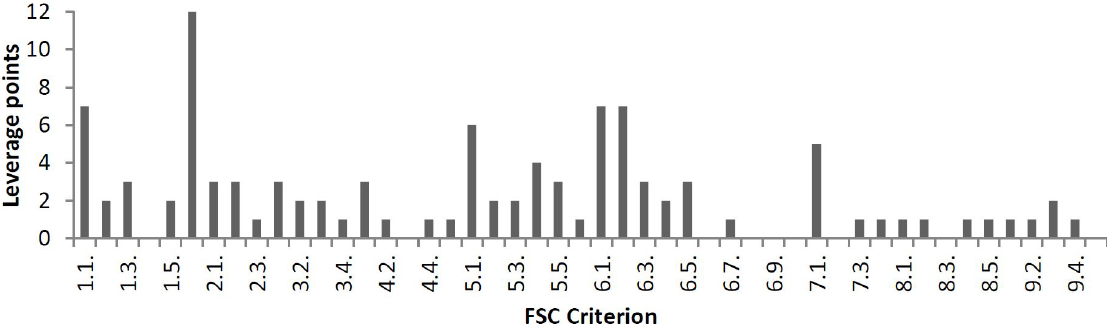
Figure 11. Histogram showing each of the FSC criteria and the frequency being referred to different contributing factors that were identified during the situation